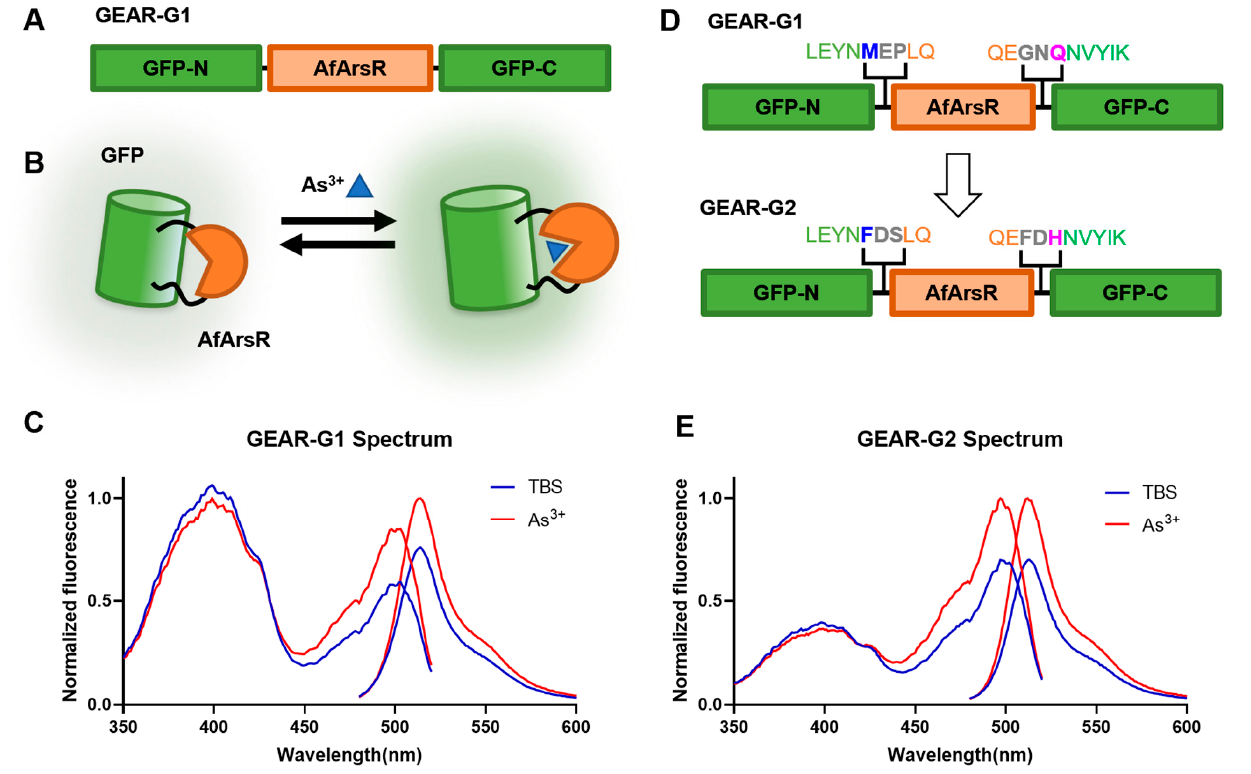
Figure 4. Design and engineering of single FP-based As 3+ biosensor prototypes GEAR-G1 and GEAR-G2. ( A ) Design and DNA construction of the genetically encoded As 3+ indicator GEAR-G1. ( B ) Schematic representation of the sensing mechanism of GEAR-G1. ( C ) GEAR-G1 normalized excitation and emission fluorescence spectrum in Tris-buffered saline (TBS) with (red) and without (blue) As 3+ . ( D ) Rational optimization of residues 145 and 148 of GFP (blue and magenta residues), the linker regions (grey residues) for improved single FP-based As 3+ biosensor prototype GEAR-G2. ( E ) GEAR-G2 normalized excitation and emission fluorescence spectrum in Tris-buffered saline (TBS) with (red) and without (blue) As 3+ .